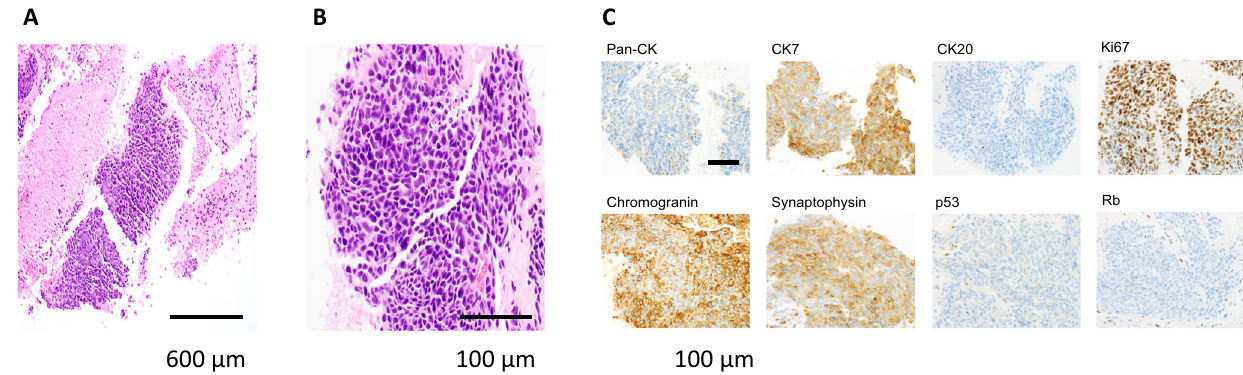
Fig. 2 Histologic fi ndings from diagnostic liver biopsy, demonstrating poorly differentiated neuroendocrine carcinoma. A Hematoxylin and Eosin (H&E), magni fi cation 100×, scale bar: 600 μ m, B H&E magni fi cation 600×, scale bar: 100 μ m). The neoplastic cells expressed CK7, chromogranin and synaptophysin, aberrant loss of P53 and RB protein expression and a high Ki67 labeling index ( C 3,3 ′ -Diaminobenzidine, magni fi cation 600×, scale bar: 100 μ